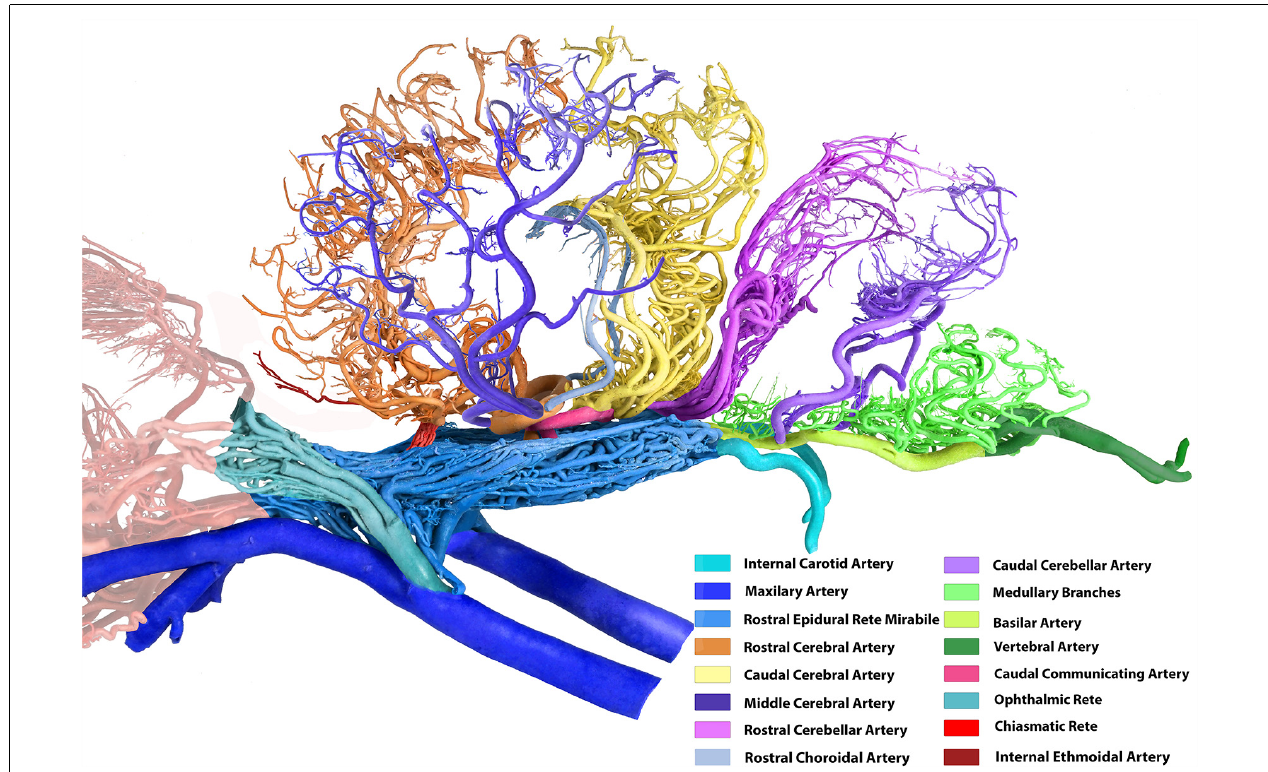
FIGURE 2 | Arterial supply to the brain in the dromedary (left lateral view). Note: middle meningeal artery was not a dominant supplier to RERM in this sample. The middle cerebral artery in the contralateral hemisphere has been removed for better image